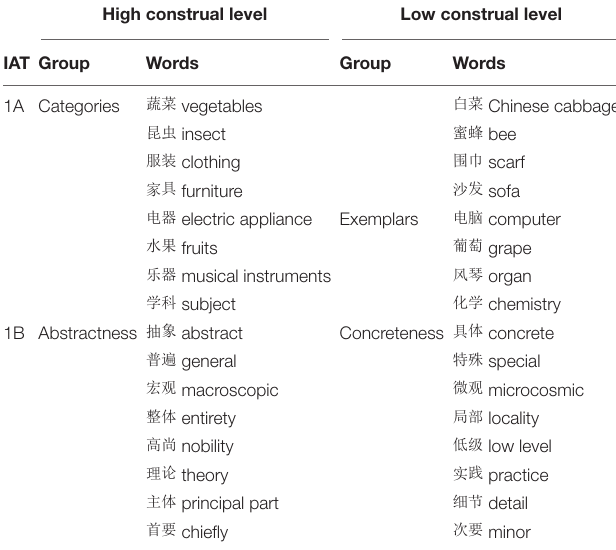
TABLE 2 | Stimuli used for construal levels in studies 1A–1B. High construal